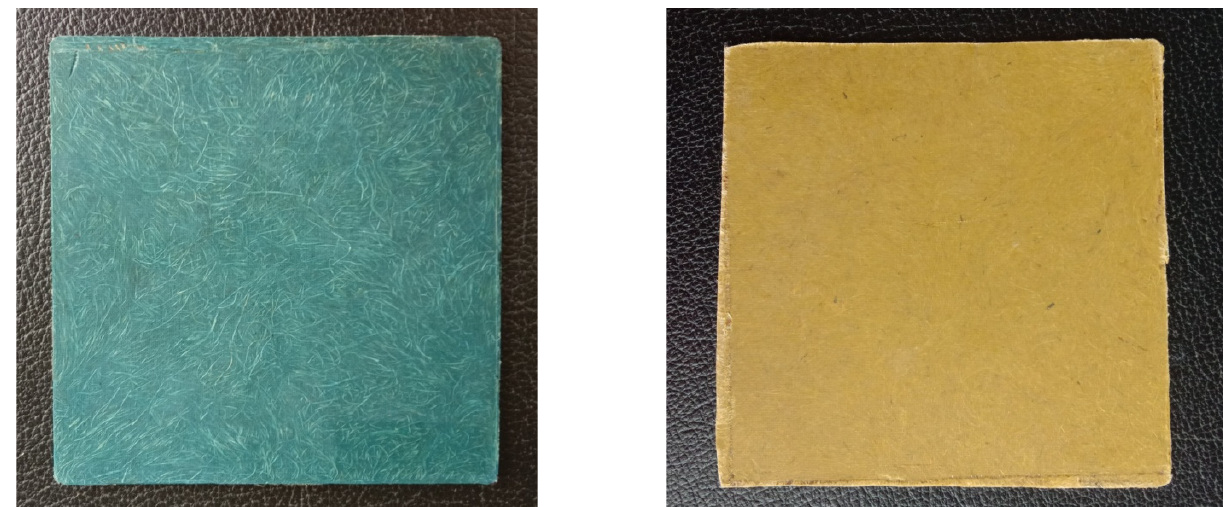
Figure 7. Images of the SWHC ( green ) and the PWHC ( yellow ). Note: Pigments were added during the composite preparation for identification.